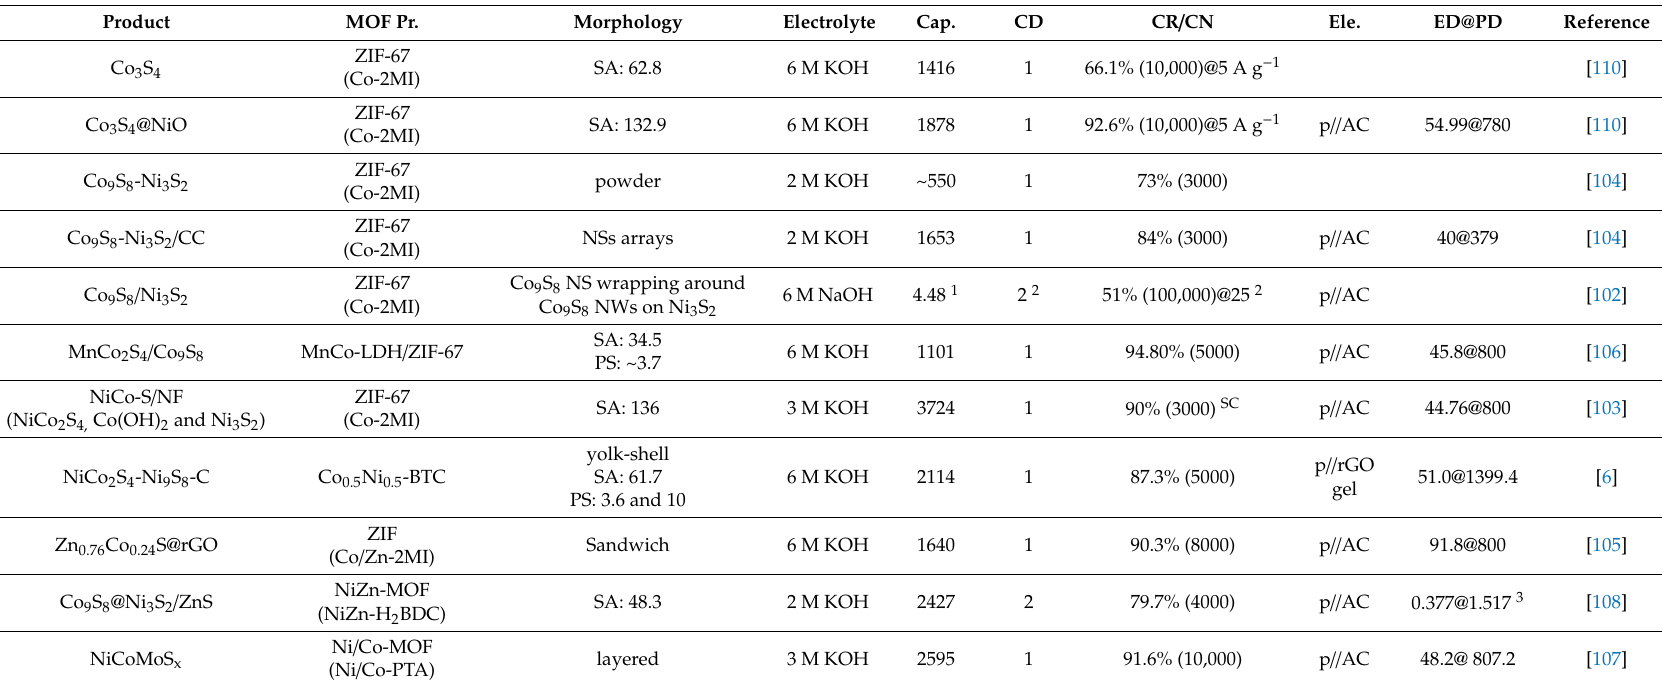
Table 4. Selected MOF-derived MS x -based electrodes for supercapacitor